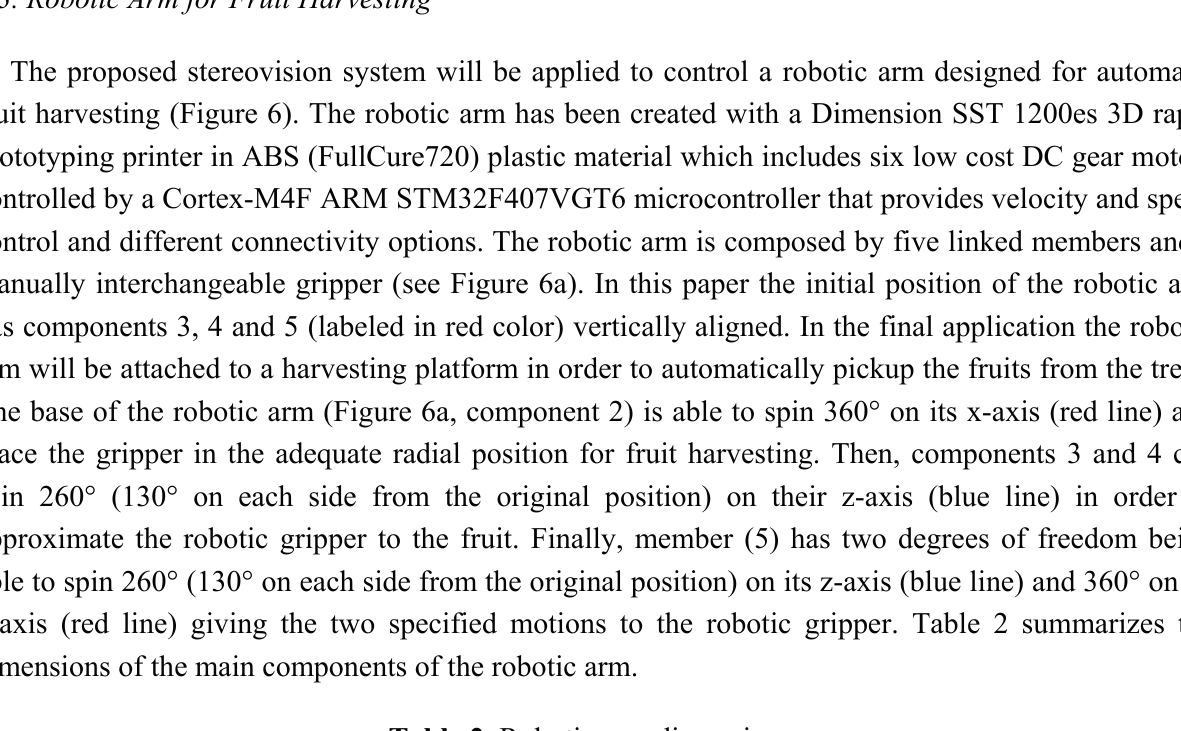
Table 2. Robotic arm